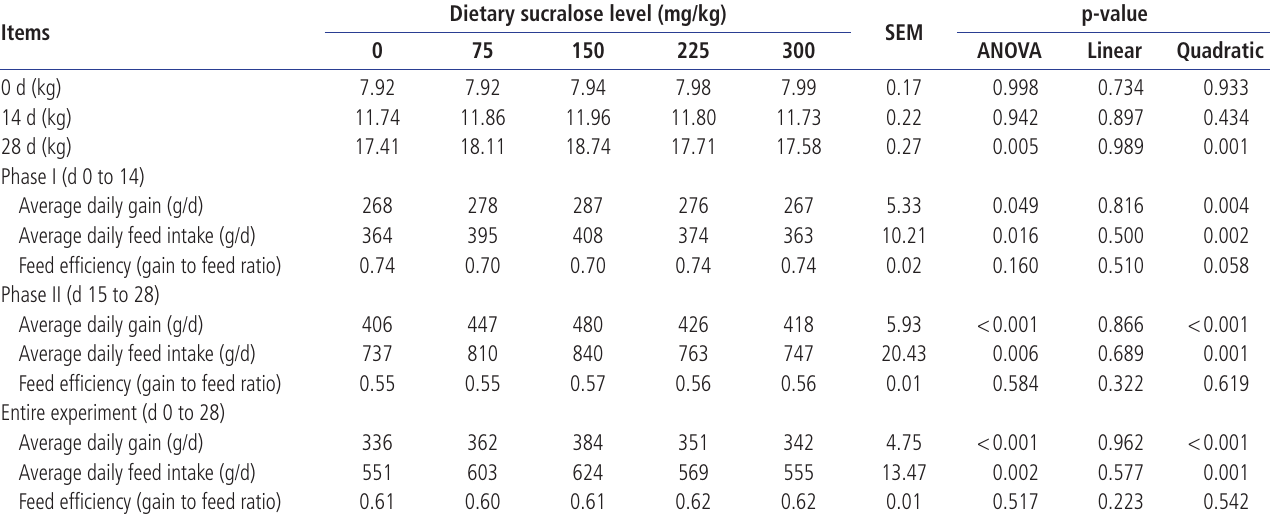
Data are the means of 6 replications.